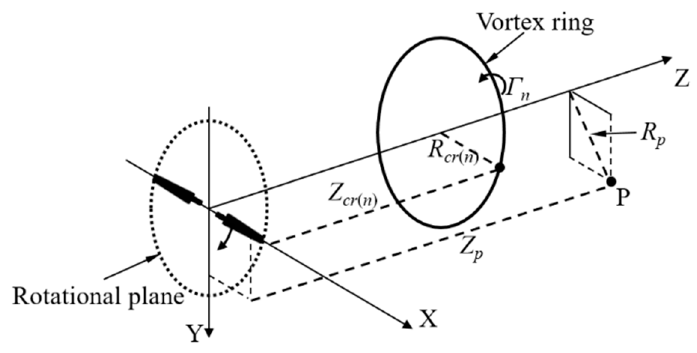
Figure 5. Schematic of the coordinate system for the induced velocity calculation of the vortex ring.